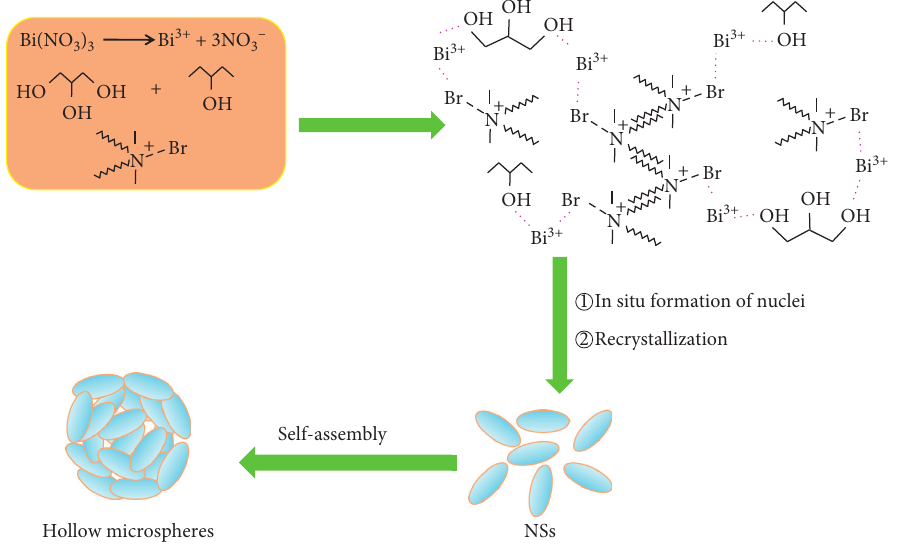
Figure 5: Schematic illustration of the formation process of the